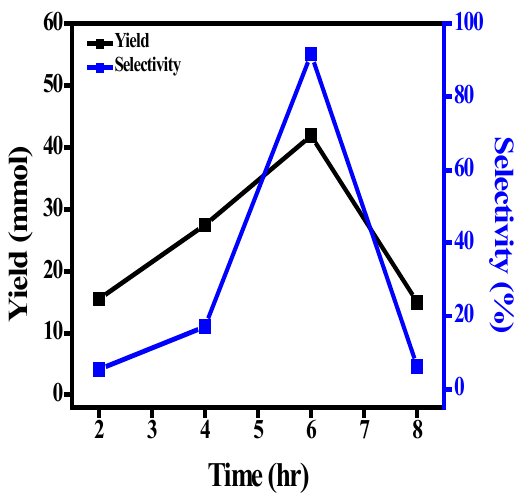
Figure 8: Effect of time on yield and selectivity of DMC production under reaction conditions: MeOH: 625 mmol, IL: 1.28 mmol, DMAP: